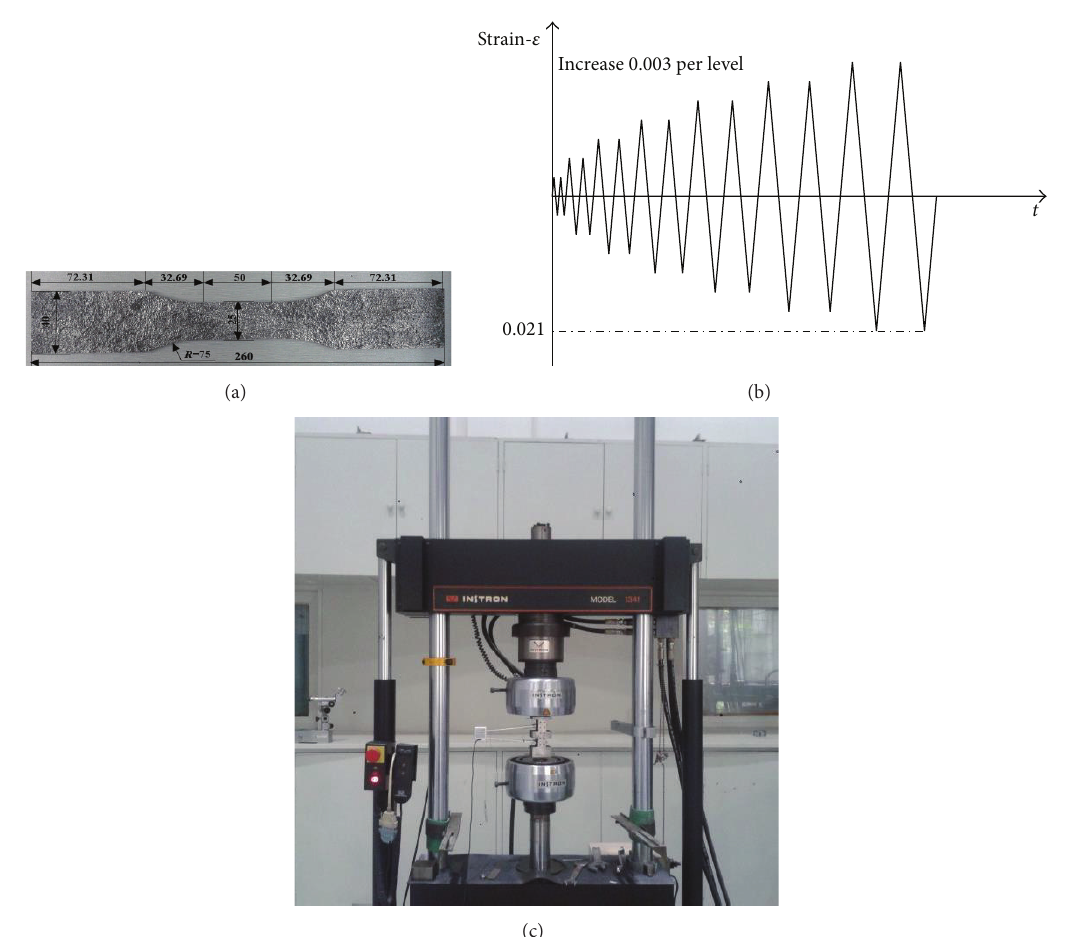
Figure 1: Size of experimental components, device, and system for